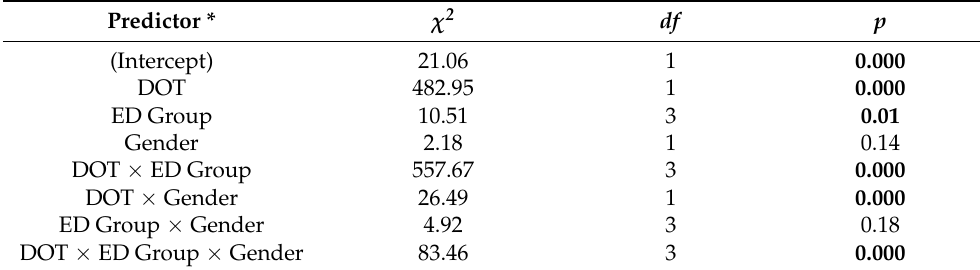
Table 2. LME model inferential statistics for change in weight